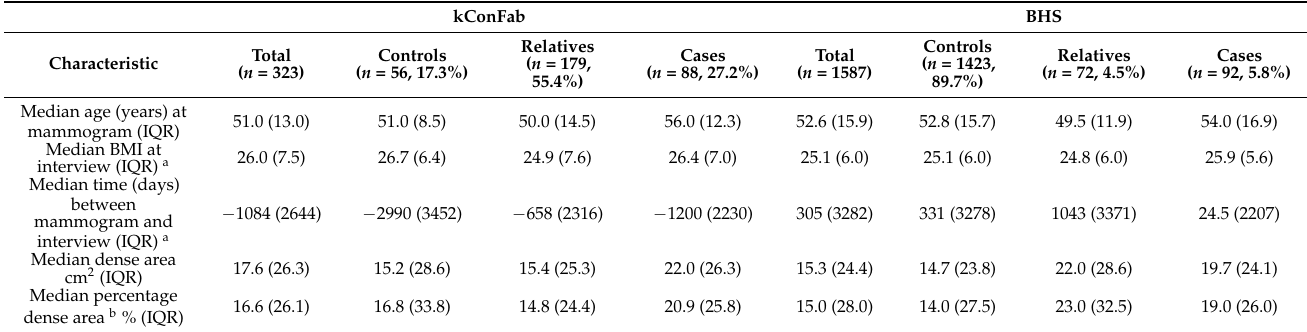
Table 1. Population characteristics for the two studies kConFab and BHS. kConFab